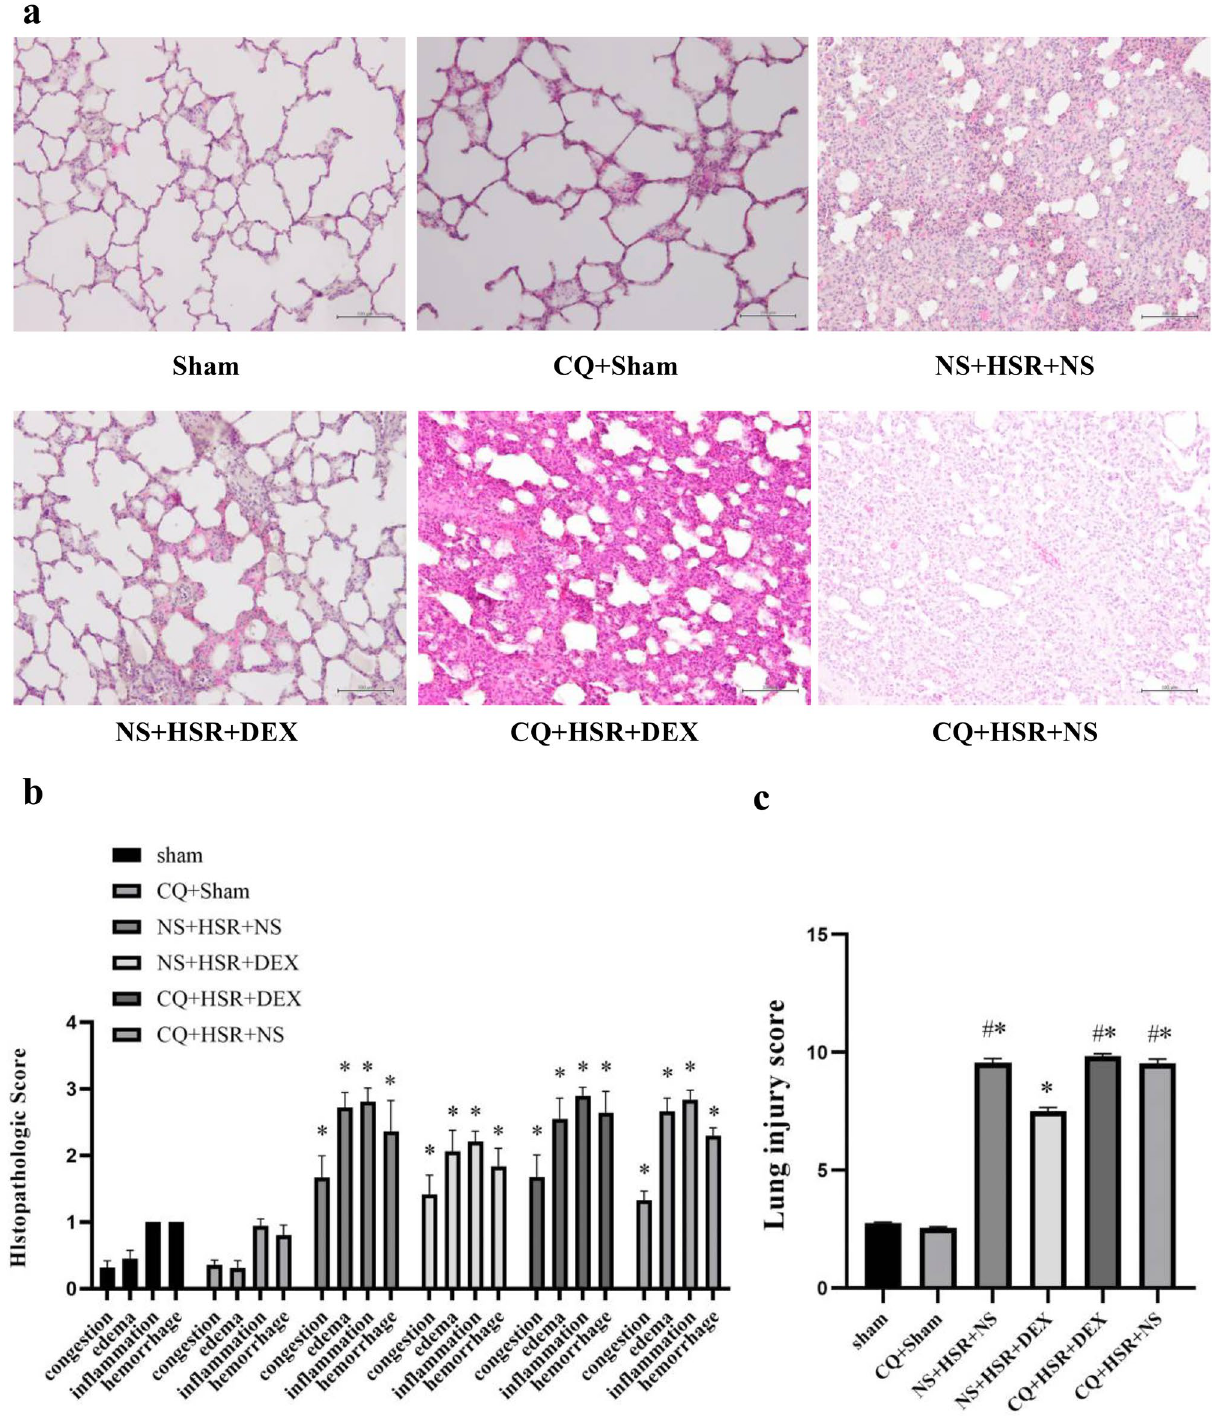
Figure 2. Histological examination of lung injury after hemorrhagic shock resuscitation (HSR). The cells were observed under a microscope (original magnification × 400). ( a ) Histological damage, such as congestion, edema, inflammation, and hemorrhage, was observed in the normal saline (NS) + HSR + NS group. However, these histopathological changes were markedly improved by dexmedetomidine (DEX) treatment. ( b,c ) The severity of lung histopathological changes was evaluated and scored based on four aspects: congestion, edema, inflammation, and bleeding. 0, none or normal; 1, mild; 2, moderate; and 3, severe. The pathological scores of the four parameters were calculated, and their sum in each group was used as the score for lung tissue injury. Consistent with the histological findings, the lung injury scores of the NS + HSR + NS group were significantly higher than those of the sham group; however, DEX treatment significantly reduced the score, and CQ had no significant effect on the score. Statistical analysis was performed using ANOVA followed by the Tukey–Kramer multiple-comparison test between groups. * p < 0.05 (vs. sham) # p < 0.05 (vs. NS + HSR +